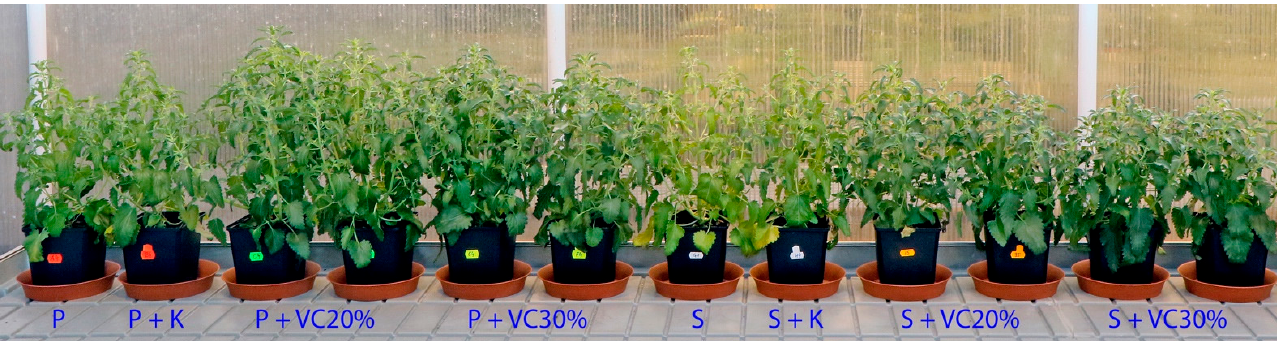
substrate pH for Dracocephalum moldavica plants grown in peat substrate or commercial garden soil for 1 week ( A ) and 8 weeks ( B ) after the start of the experiment. Results are means ± SE from five replicates for each treatment, four measurements per replicate. Means with identical letters are not considered statistically significantly different ( p < 0.05).